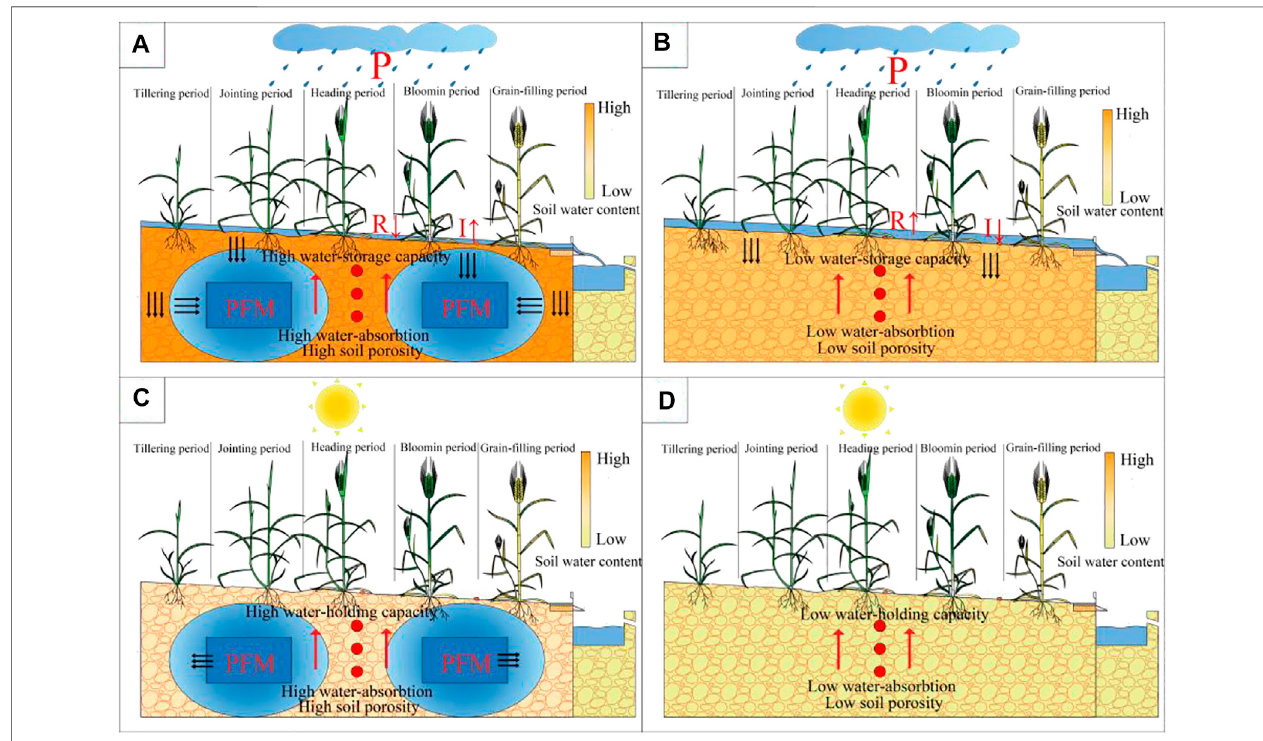
FIGURE 1 | PFM embedding in the farmland increases soil porosity, which bene fi ts the increase of in fi ltration and the reduction of runoff. (A – D) represent the changes of soil water content in the different scenarios, respectively.